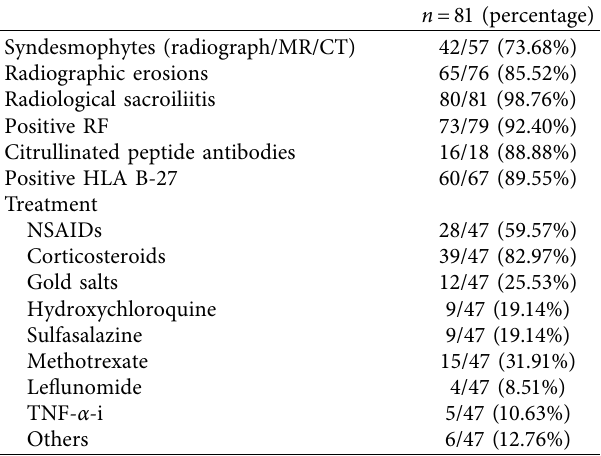
Table 2: Clinical and epidemiological characteristics of 81 patients with concurrent RA and AE.